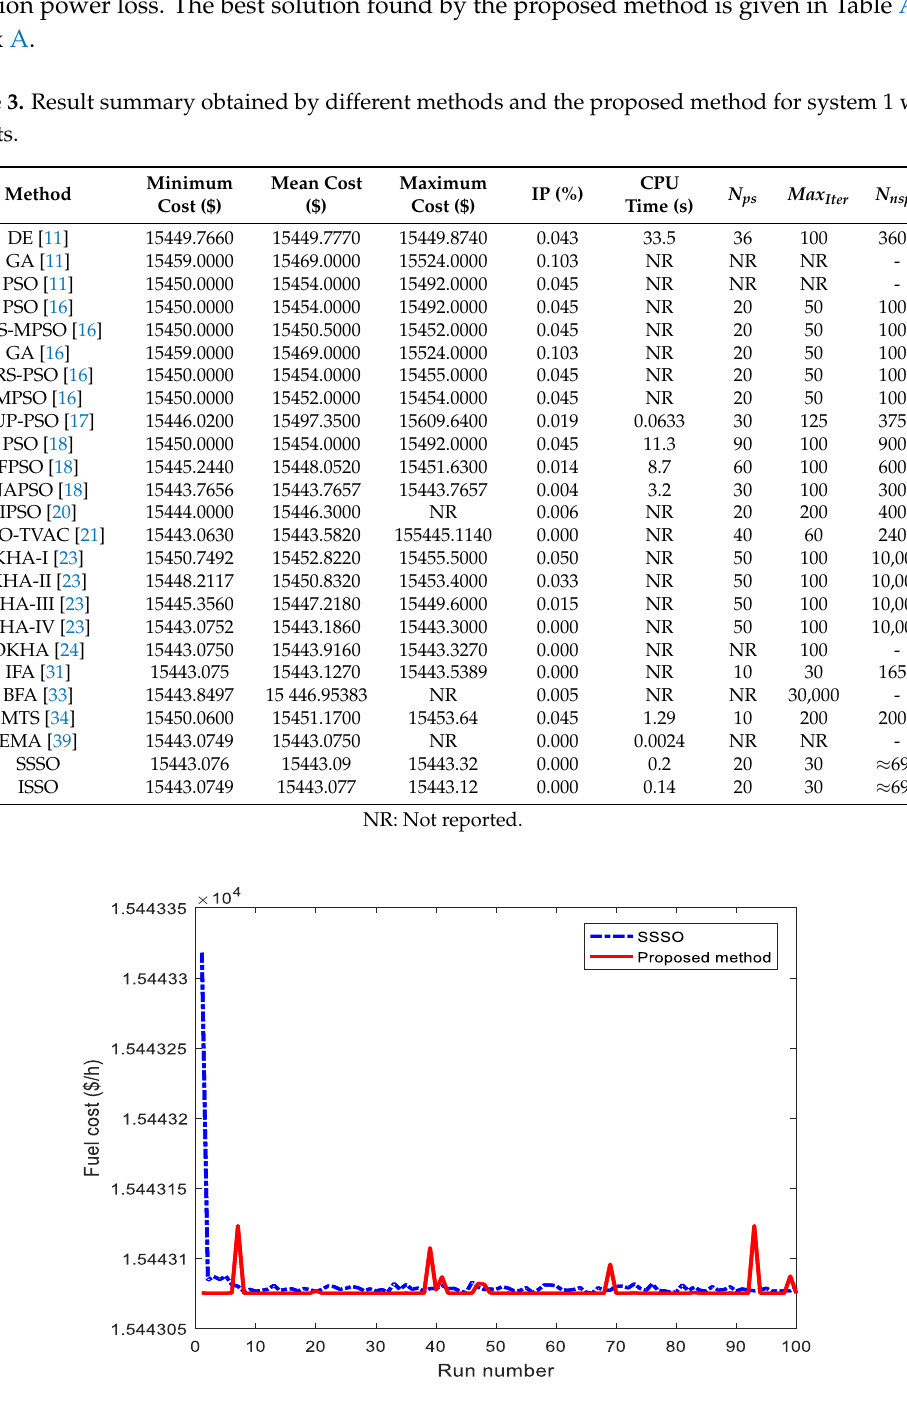
Figure 3. The best fitness functions of 100 runs obtained by SSSO and ISSO for system 1.